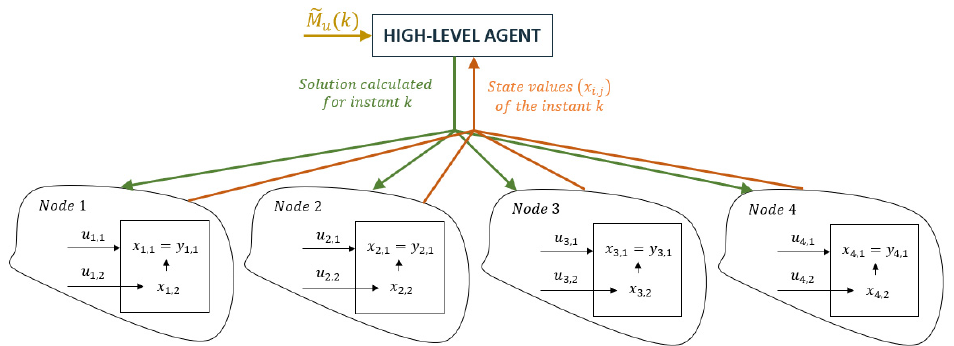
Figure 6. Centralised MPC applied to the use case.